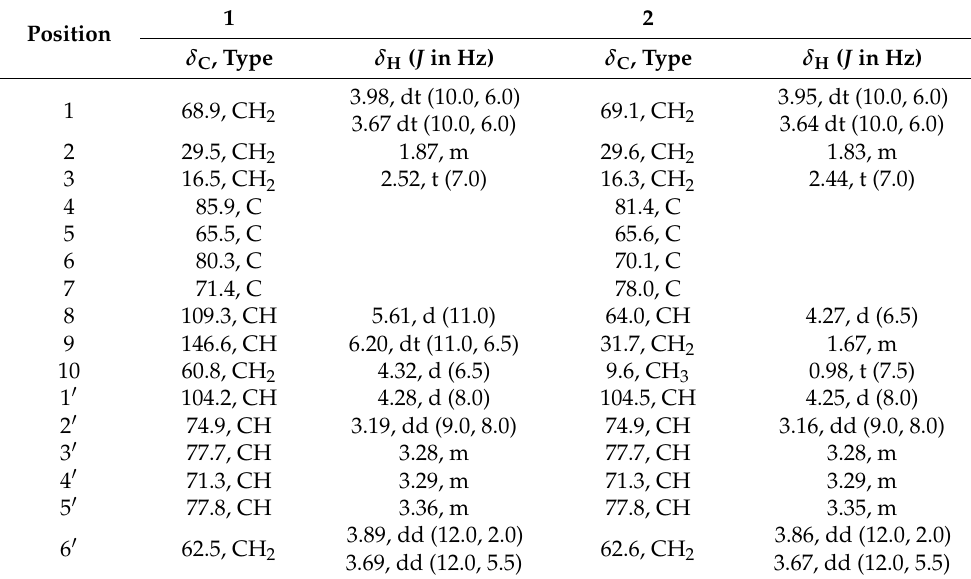
Table 1; ESIMS (positive-ion mode) m / z 349.1 [M + Na] + ; HRESIMS (positive-ion mode) m / z 349.1252 [M + Na] + (calculated for C 16 H 22 O 7 Na, 349.1263). Table 1. 1 H and 13 C NMR data for compounds 1 and 2 in CD 3 OD. a